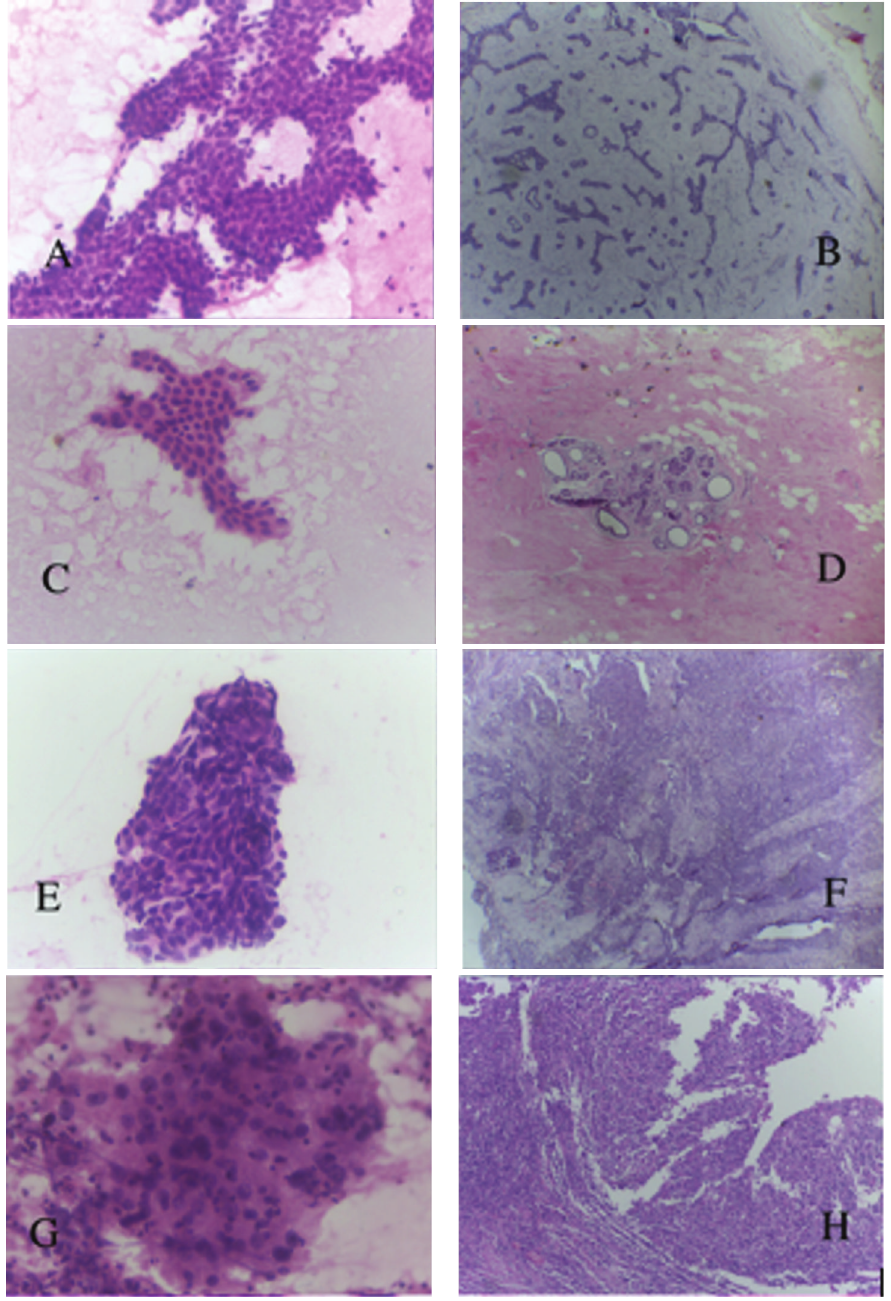
Figure 1: Photomicrograph showing smear preparations diagnosed as C2 (A), C3 (C), C4 (E), and C5 (G) and their corresponding diagnoses: fibroadenoma (B), fibrocystic changes (D), and invasive ductal carcinoma of no special type ((F) and